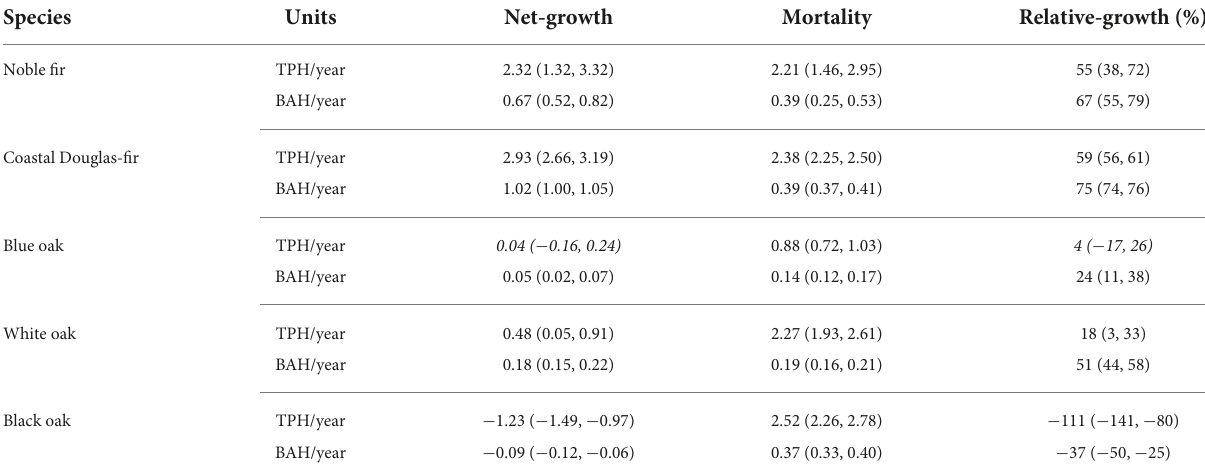
TABLE 4 Estimate and equal-tailed 90% confidence intervals for net-growth, mortality, and relative-growth (i.e., net-growth expressed as a percentage of gross growth, which is net-growth plus mortality) for the five species in terms of the BAH/year and TPH/year (units) on forest land where the species was